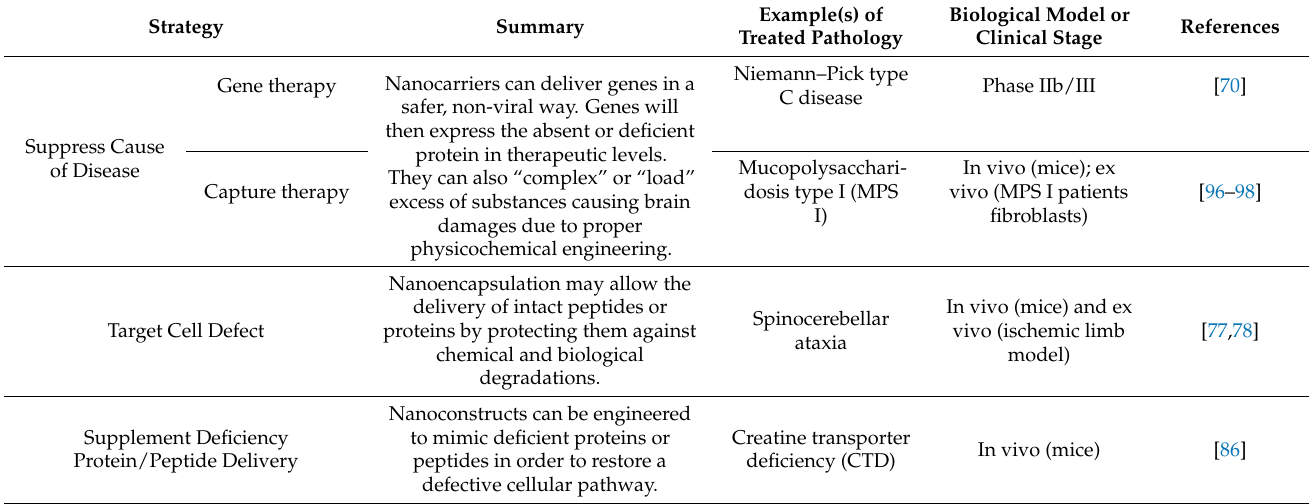
Table 3. Nanotherapeutic approaches currently reported for rare CNS